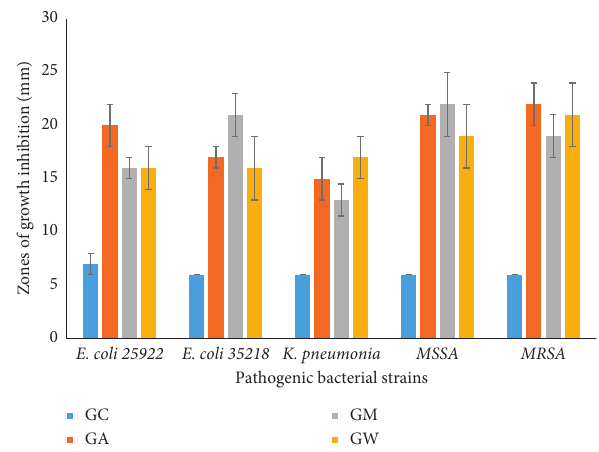
Figure 6: Antibacterial activity of P. grandiflora tuber extract conjugates with biologically synthesized gold nanoparticles against selected pathogenic bacteria. GB: biologically synthesized gold nanoparticles, GA: gold nanoparticles and acetone extract, GM: gold nanoparticles and methanol extract, and GW: gold nano- particles and water extract.